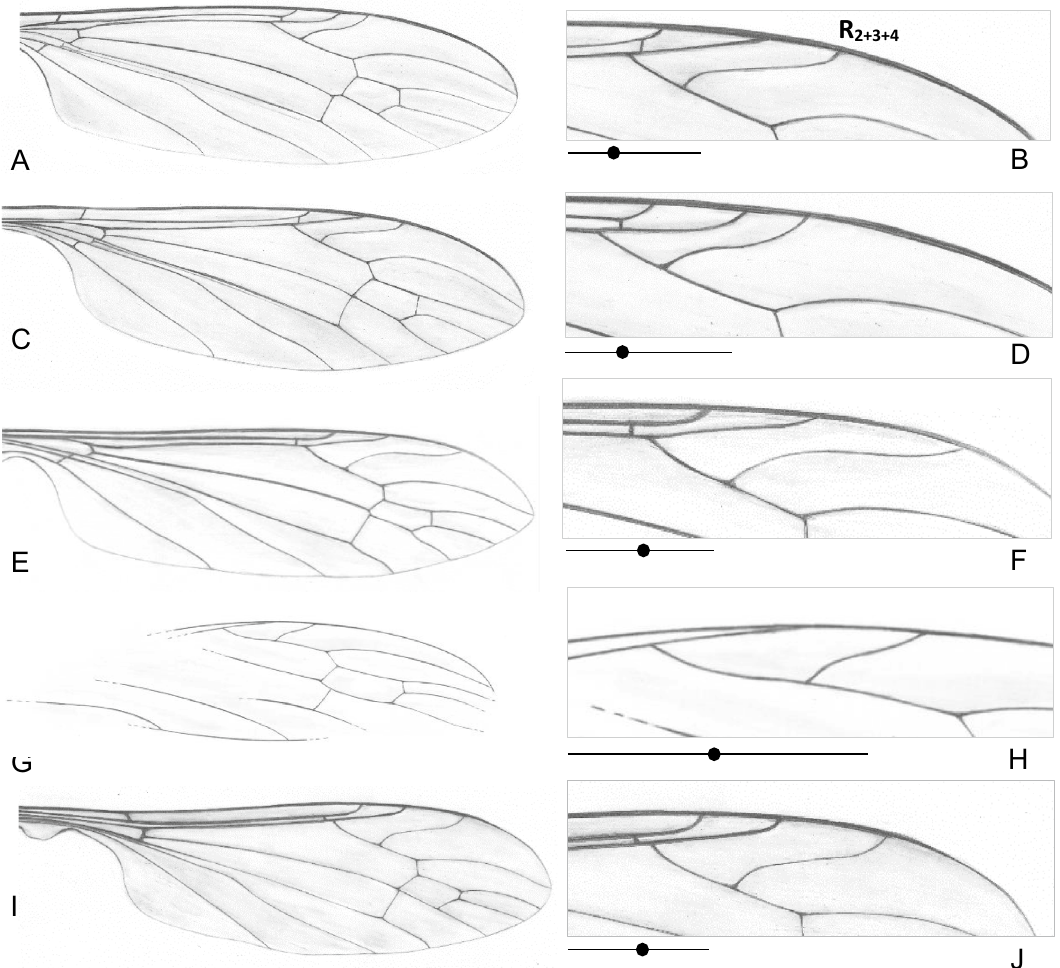
Figure 6. Wing venation of fossil Toxorhina ( Ceratocheilus ): ( A–D ) Toxorhina ( Ceratocheilus ) caucasiensis Krzemiński and Freiwald 6 ; ( E , F ) Toxorhina ( Ceratocheilus ) eridanus Meunier 5 , ( G , H ) Toxorhina ( Ceratocheilus ) mexicana Kopeć, Kania, Krzemiński, 2016 (after Kopeć et al . 7 ), ( I , J ) Toxorhina ( Ceratocheilus ) christelius sp. nov. ( B , D , F , H , J )—enlarged view of part of wing with position of vein R 2+3+4 with a diagram showing the position (black point) of the Rs